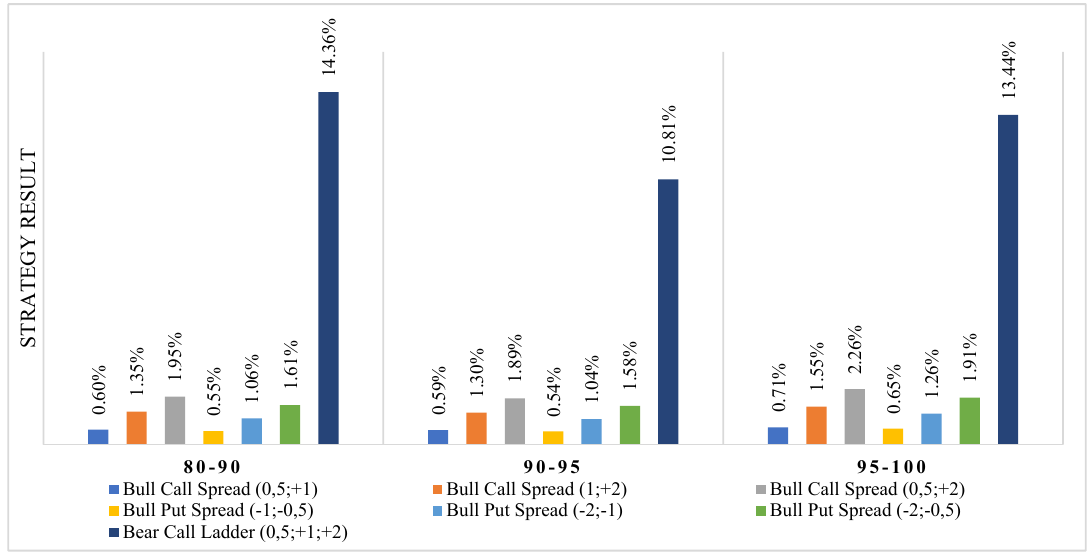
Figure 9. Bear put spread, bear call spread, and bull put ladder results for declines of WTI crude oil prices ranging from 0% to 5%.